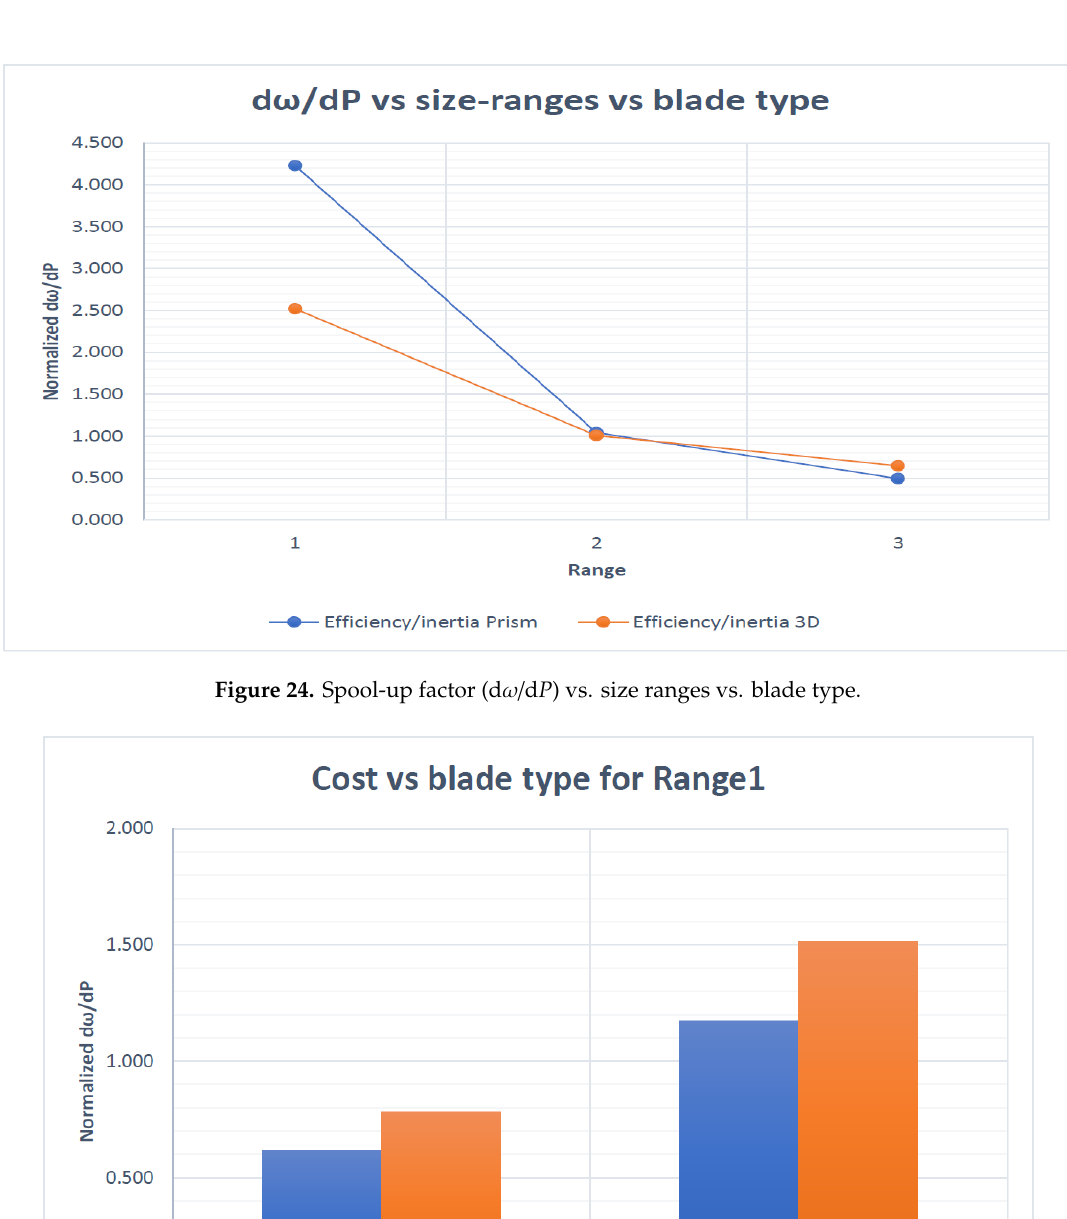
Figure 24. Spool-up factor (d ω /d P) vs. size ranges vs. blade type.